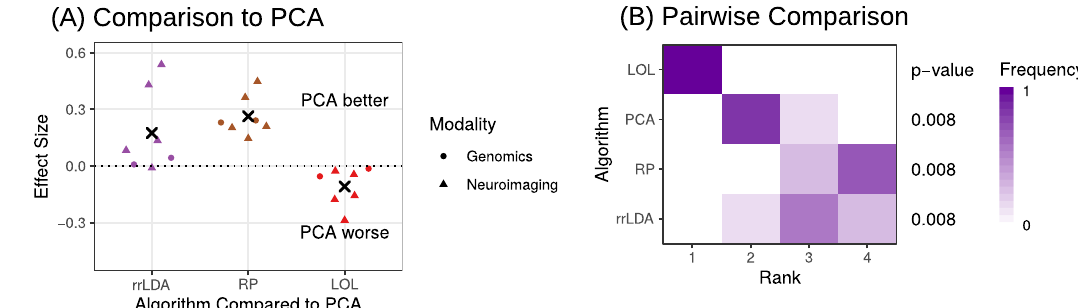
Fig. 3 Comparing various dimensionality reduction algorithms on two real datasets: neuroimaging and genomics. A Beeswarm plots show the classi fi cation performance of each technique with respect to PCA at the optimal number of embedding dimensions, the number of embedding dimensions with the lowest misclassi fi cation rate. Performance is measured by the effect size, de fi ned as κ ( LDA ∘ PCA ) − κ ( LDA ∘ embed), where κ is Cohen ’ s Kappa, and embed is one of the embedding techniques compared to PCA . Each point indicates the performance of PCA relative the other technique on a single dataset, and the sample size-weighted average effect is indicated by the black “ x. ” LOL always outperforms PCA and all other techniques. B Frequency histograms of the relative ranks of each of the embedding techniques on each dataset after classi fi cation, where a 1 indicates the best relative classi fi cation performance and a 4 indicates the worst relative classi fi cation performance, after embedding with the technique indicated. Projecting fi rst with LOL provides a signi fi cant improvement over competing strategies (Wilcoxon signed-rank test, n = 7, p value = 0.008) on all